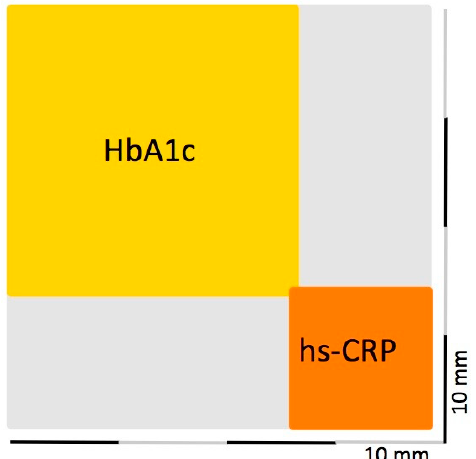
Figure 2. Square in mm 2 representing the mean PISA values for patients diagnosed as having severe periodontitis and depicting the surface area explained by glycated hemoglobin (HbA1c, yellow) and high-sensitivity C reactive Protein (hs-CRP, orange) levels. The grey area identifies the surface area attributable to other unexplored factors that influence the PISA.